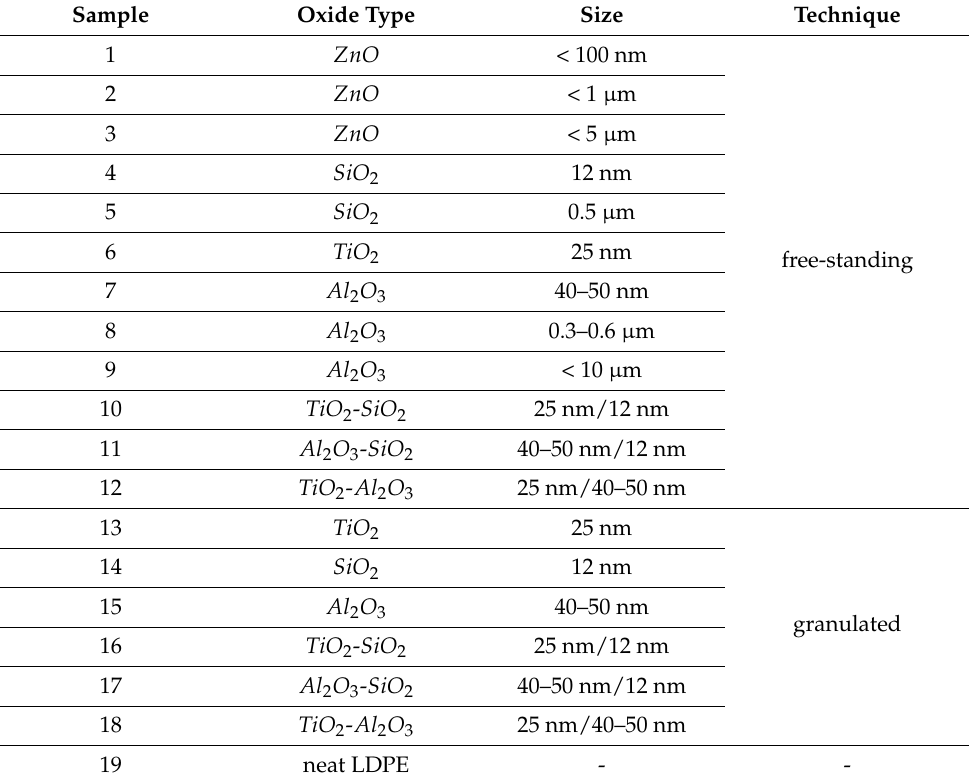
Table 3. Detailed account of nanocomposite films produced, indicating active material, particle size, and type of embedded dispersoid. Sample Oxide Type Size Technique